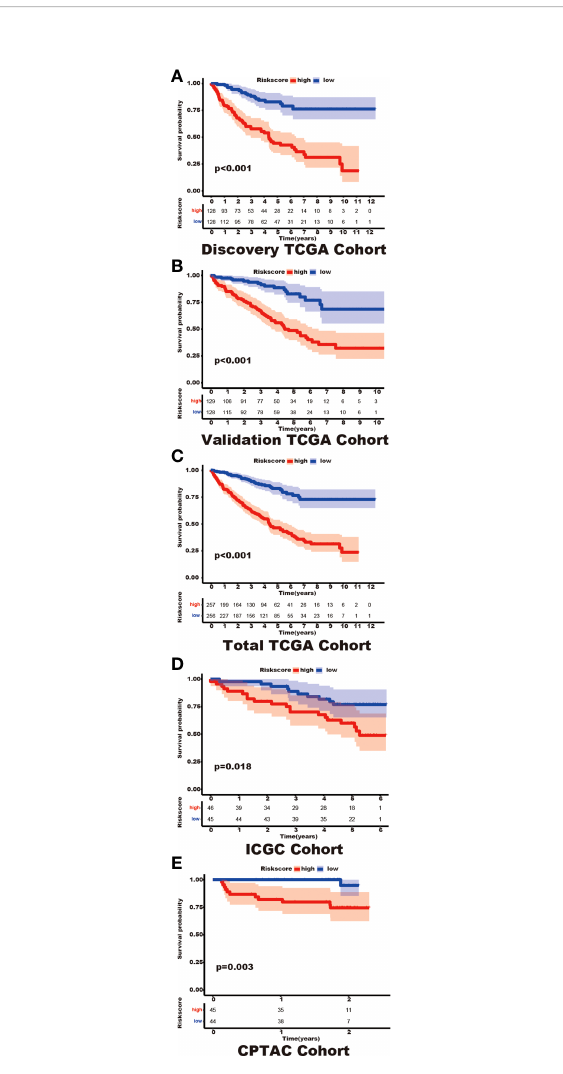
FIGURE 3 The differential prognosis in patients with different TRGs risk groups. Log-rank methods had compared the survival status in different TRGs risk groups, the patients in the high TRGs risk group presented worse outcomes in these fi ve cohorts. (A) discovery TCGA cohort; (B) validation TCGA cohort; (C) total TCGA cohort; (D) ICGC cohort; (E) CPTAC